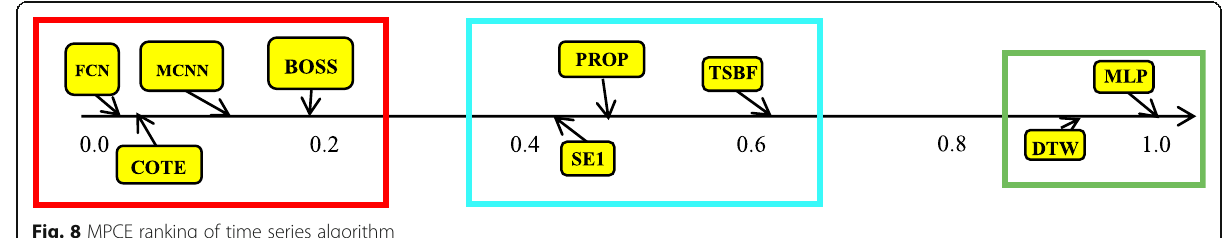
Fig. 8 MPCE ranking of time series algorithm